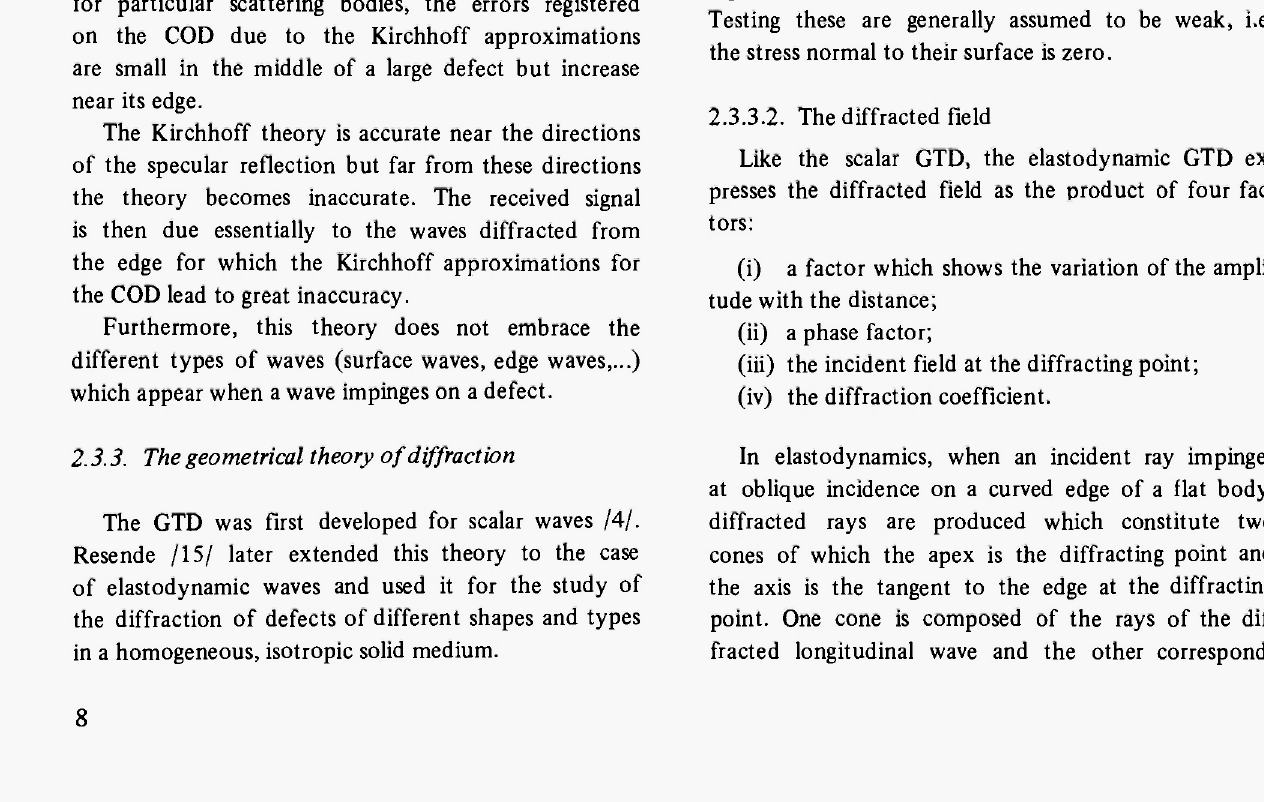
Diffraction by a plane defect. Configuration used for computation using the Kirchhoff